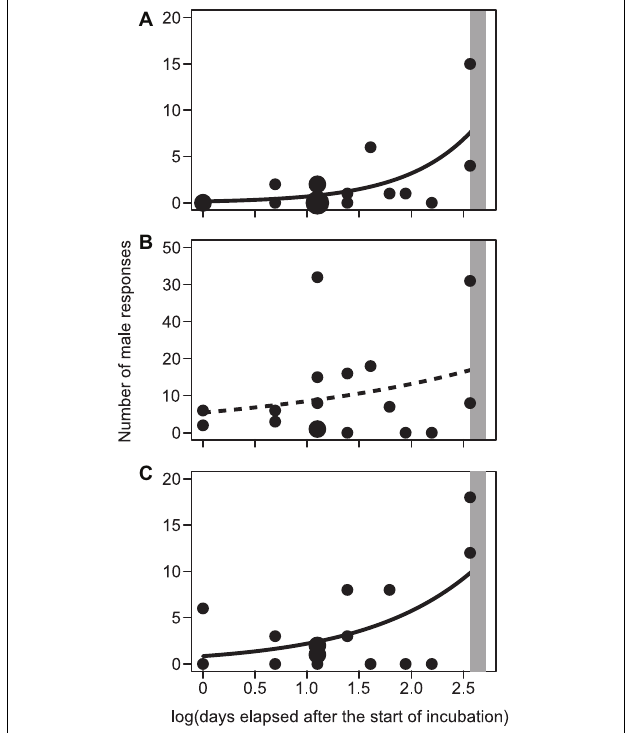
FIGURE 2 | Relationship between the number of male responses to the playback of male enticement calls (A) , male songs (B) , and nestling food-begging calls (C) in relation to the progress of incubation period, measured as log(days elapsed after the start of incubation). Lines indicate simple Poisson regressions [using the glm function with family = “quasipoisson”; y = slope ( ± SE)x + intercept ( ± SE); a: y = 1.54 ( ± 0.47)x –1.92 ( ± 0.99); b: y = 0.44 ( ± 0.42)x + 1.69 ( ± 0.71); c: y = 0.96 ( ± 0.41)x –0.17 ( ± 0.78)]. Circle size indicates the number of overlapping points. Dashed line indicates non-significant regression lines. Shaded bars indicate mean hatching dates (13–15 days; Turner, 2006). I confirmed that all eggs remained unhatched during our experiment.